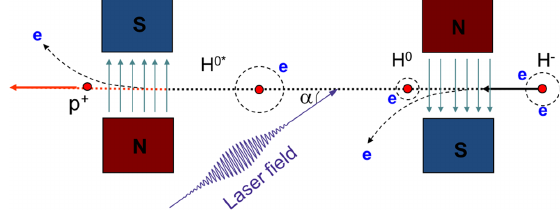
FIG. 1. Schematic of the laser stripping concept in this experi- ment, showing Lorentz stripping of the first electron by a dipole magnet in the first step (far right), resonant excitation of the second electron by the laser in the second step (middle), and finally stripping of the excited electron by the second dipole magnet (left). This figure is reproduced from Ref.